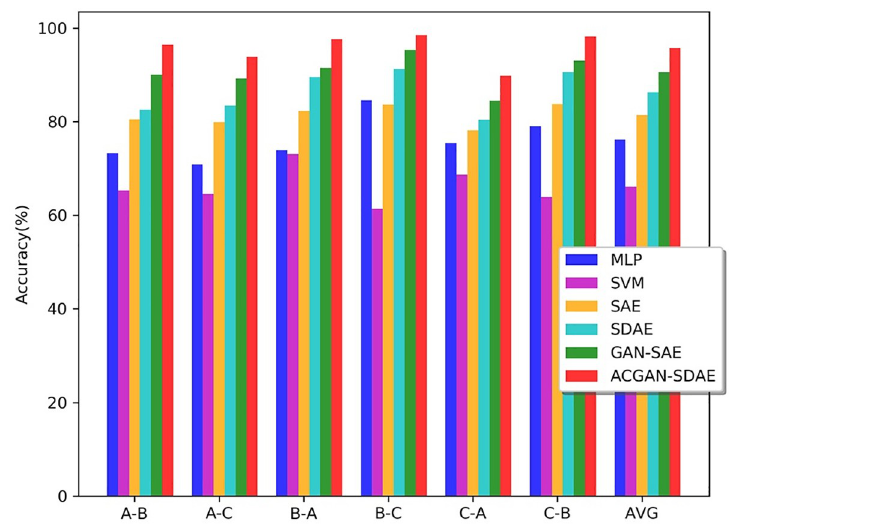
Fig 14. Diagnosis accuracy of different models under across different load domains.